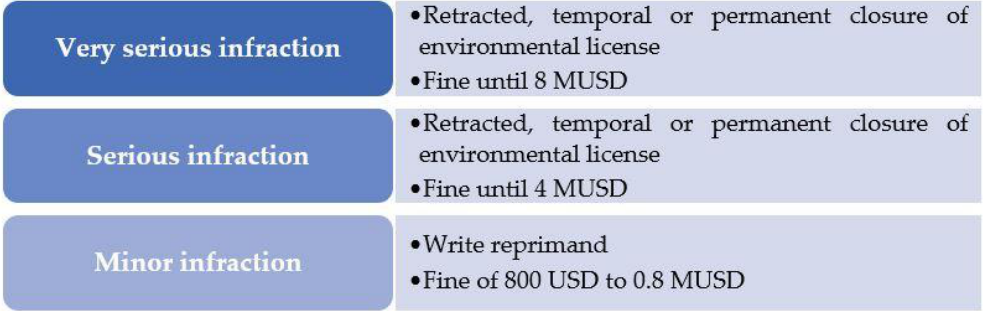
Figure Figure 2. Ranking of sanctions attending to the infraction severity, adapted and updated from Meth- odological bases for the determination of environmental sanctions of SE [32]. Data source: (https://portal.sma.gob.cl/index.php/download/bases-metodologicas-para-la-determinacion-de- sanciones-ambientales-2017/) (accessed on 11 January 2022).